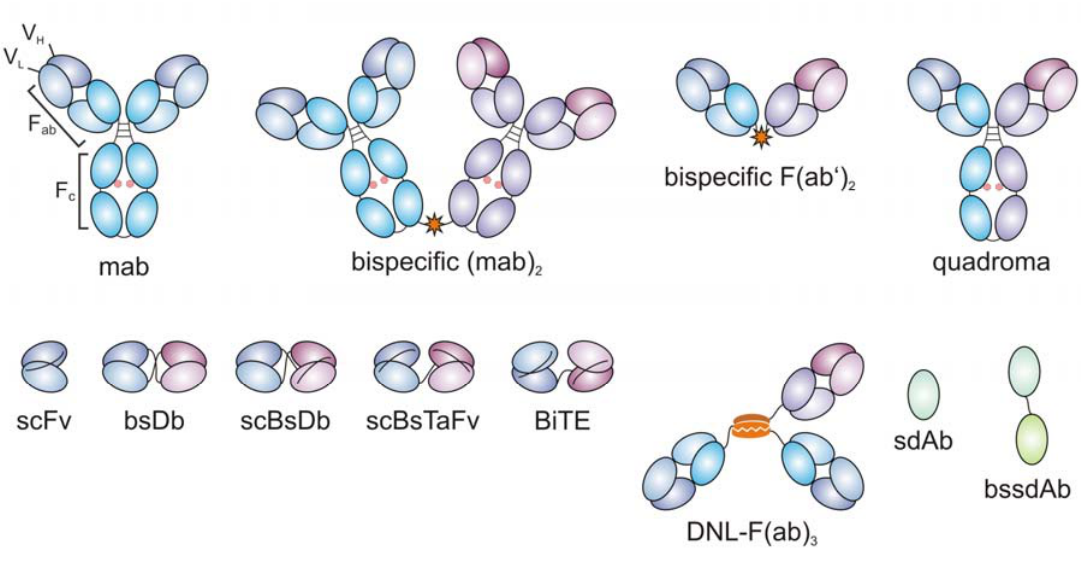
Figure 1. Evolution of bispecific antibodies. First bispecific antibodies were developed by chemical cross-linking of monoclonal antibodies (mabs) or of Fab fragments, or by quadroma technology (upper row). Recombinant antibody engineering allowed for the generation of small recombinant bispecific antibodies comprising the variable heavy (V ) H ) domains of the parental mabs (lower row). scFv: single-chain fragment and light (V L variable; bsDb: bispecific diabody; scBsDb: single-chain bispecific diabody; scBsTaFv: single-chain bispecific tandem variable domain; DNL-(Fab) : dock-and-lock trivalent Fab; 3 sdAb: single-domain antibody; bssdAb: bispecific single-domain antibody (only formats discussed in this manuscript are included, additional formats reviewed in